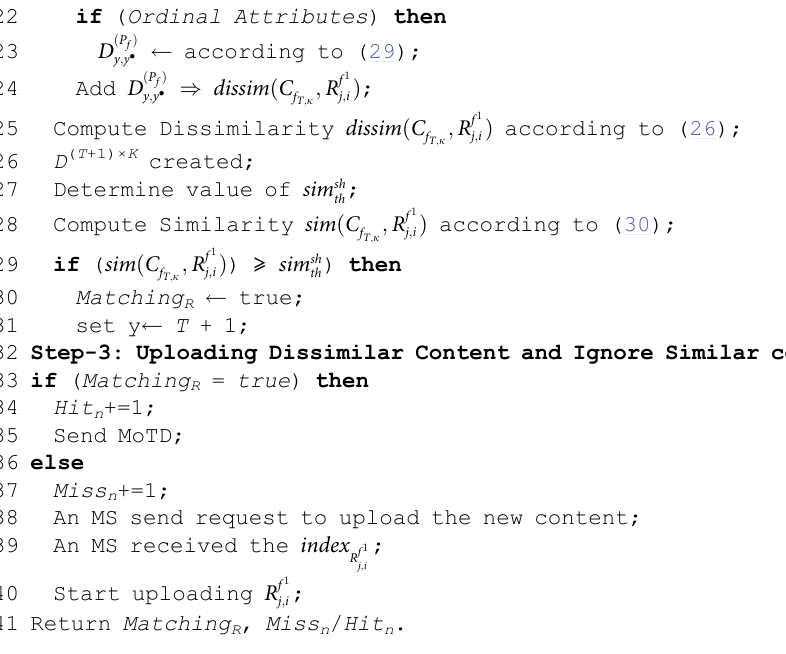
Algorithm 3 : Content Segmentation with Distributed Placement (CSDP)